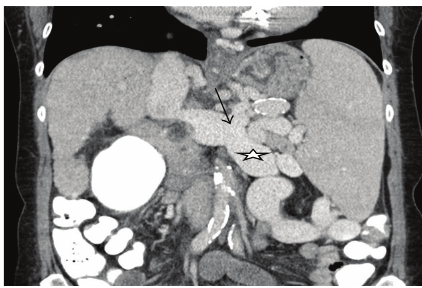
Figure 1: Preoperative CT imaging showing the splenorenal shunt (arrow) and a splenomegaly (left renal vein = star).